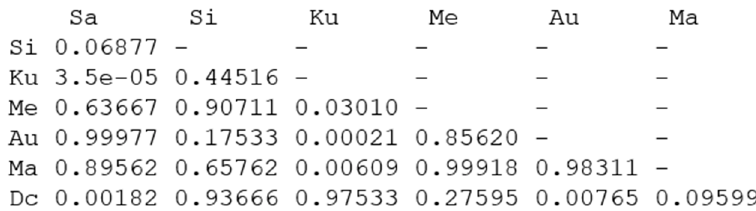
Figure 7. Resulting p -values of the Nemenyi multiple comparison test. For p -values <= 0.05, we can reject the null hypothesis, i.e., there is no significant difference in overall ranking between a pair of CO frameworks).